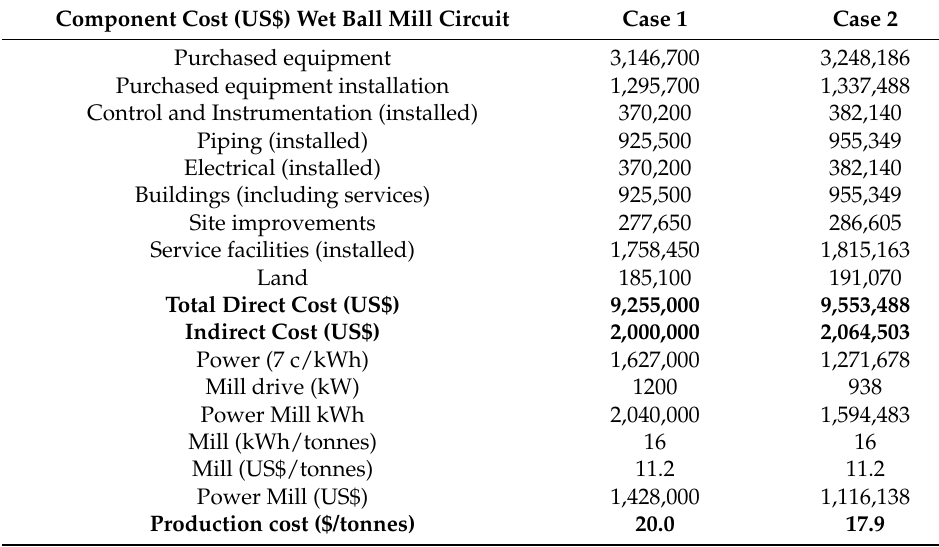
Table 6. A direct cost comparison between Case 1 and Case